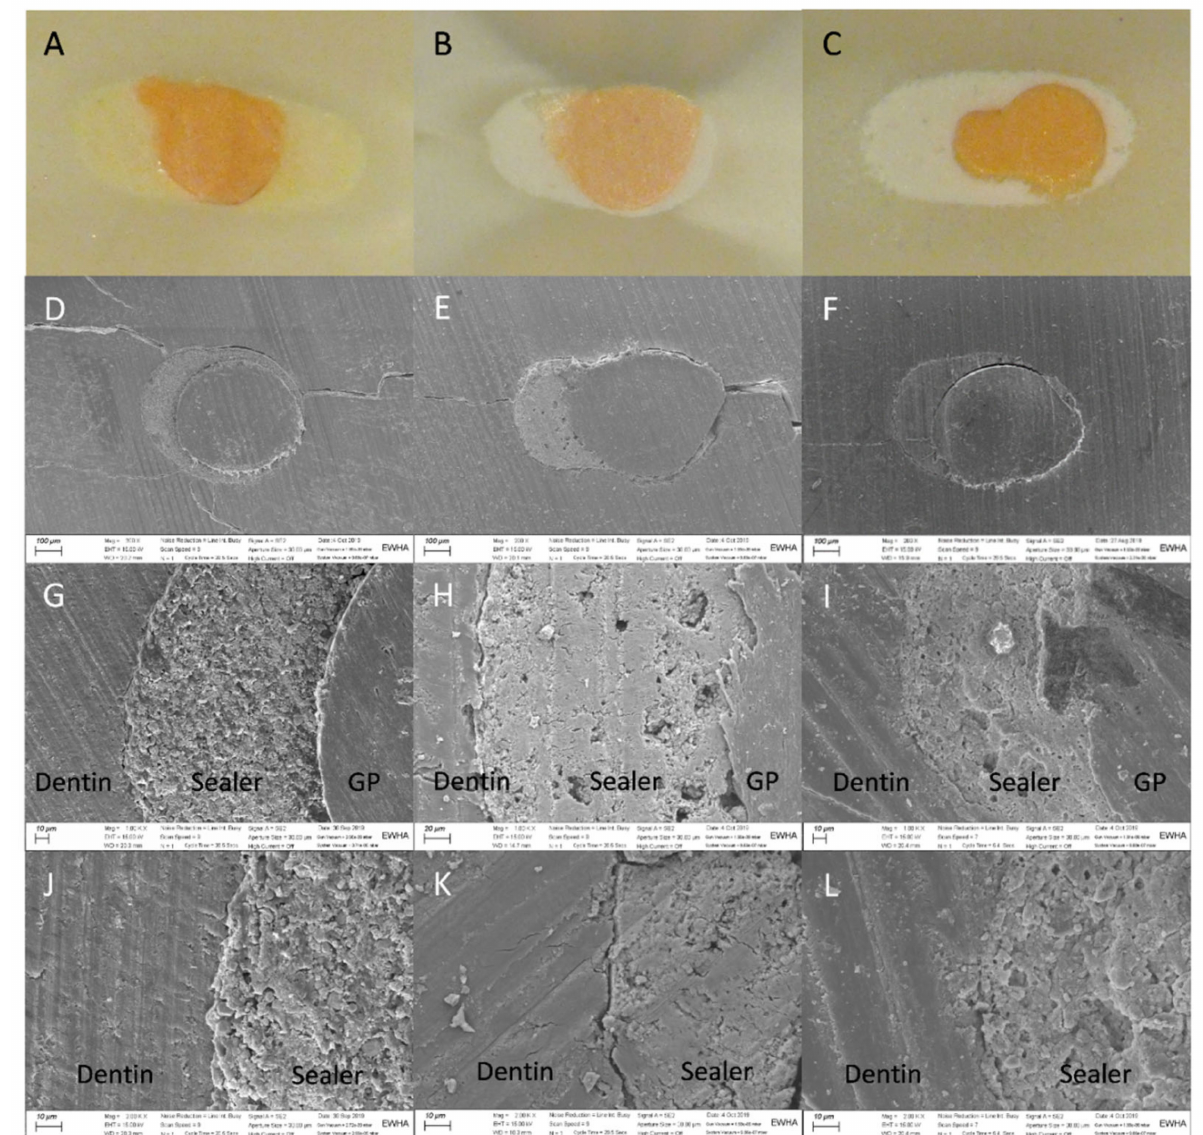
Figure 2. Light microscopy and SEM images of the dentin–sealer interface taken at magnifications of 20, 200, 1000, and 2000 × . ( A , D , G , J ) AH Plus with the continuous wave technique (CW group), ( B , E , H , K ) EndoSequence BC sealer with the single-cone technique (SC group), and ( C , F , I , L ) EndoSequence BC ultrasonic with the single-cone technique accompanied by ultrasonic activation (SCU